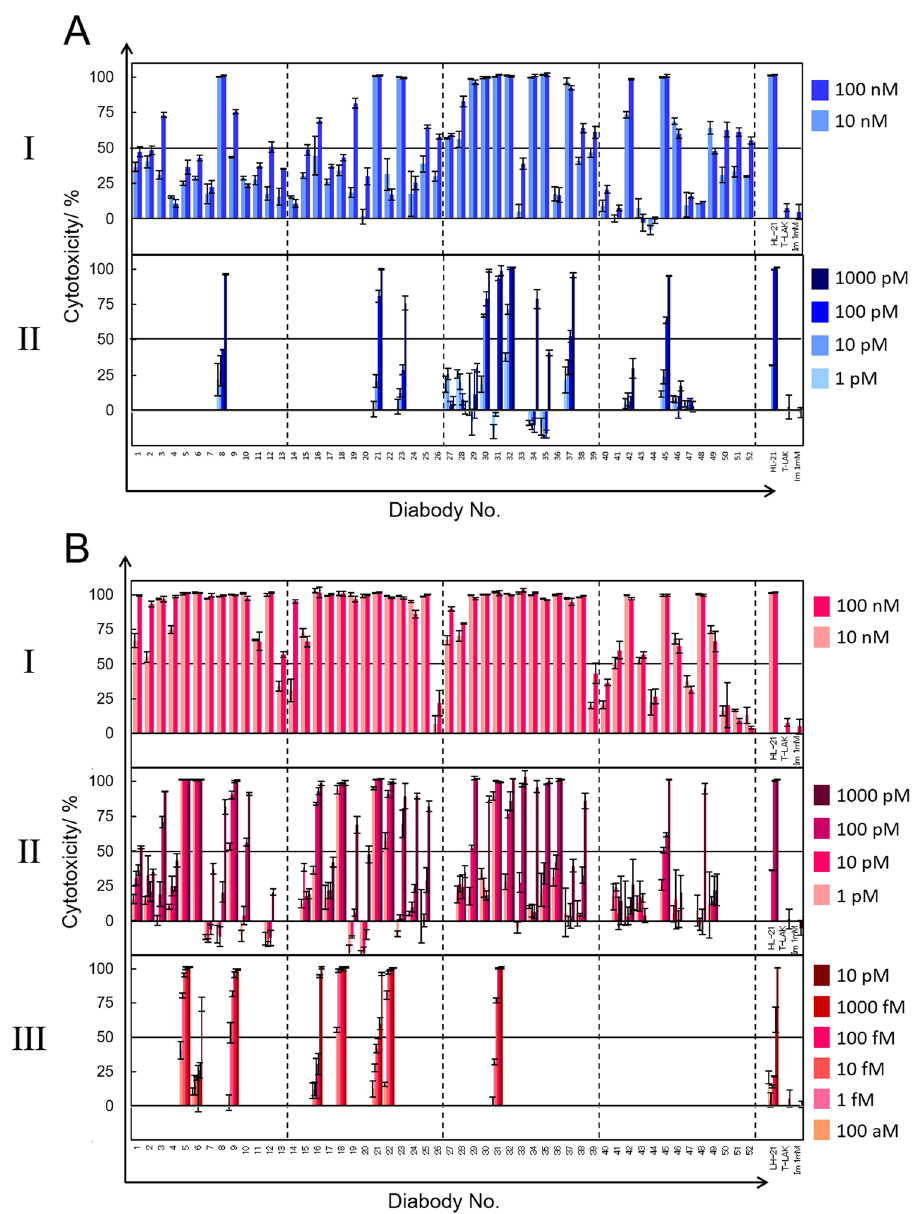
Figure 2. Cytotoxicity screening for IMAC-refined diabodies. ( A ) HL-type diabodies were added at concentrations of 10 nM or 100 nM (I), or 1 pM to 1 nM (II). ( B ) LH-type diabodies were added at concentrations of 10 nM or 100 nM (I), or 1 pM to 1 nM (II), or 0.1 fM to 10 pM (III). All the experiments were conducted three times, and data are presented as means ± S.D. In the horizontal axis, T-LAK indicates experiments without diabody but with T-LAK cells, and Im (1 mM) indicates experiments without diabody or T-LAK cells but with 1 mM imidazole. Details of the diabodies nos 1–52 are presented in Table